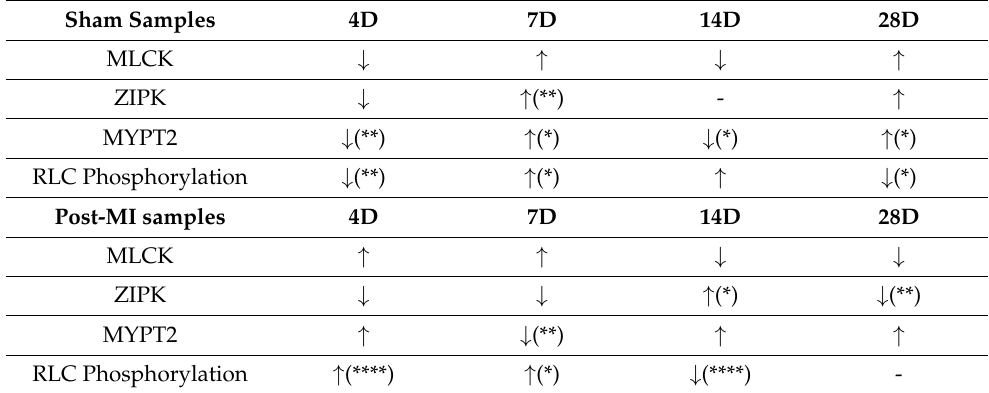
Table 2. Summary of changes in the enzyme expression levels in post-MI and sham populations of mice. Arrows represent increases or decreases in normalised enzyme expression or RLC phosphory- lation with respect to the previous timepoint. Note: ‘-’ indicates no change from previous timepoint. Asterisks indicate significant changes from the previous timepoints, validated by unpaired one-tailed t -test or with Welch’s correction. Note: * p < 0.05, ** p < 0.01, **** p < 0.0001. Sham Samples 4D 7D 14D 28D MLCK ↓ ↑ ↓ ↑ ZIPK ↓ ↑ (**) - ↑ MYPT2 ↓ (**) ↑ (*) ↓ (*) ↑ (*) RLC Phosphorylation ↓ (**) Post-MI samples 4D MLCK ZIPK RLC